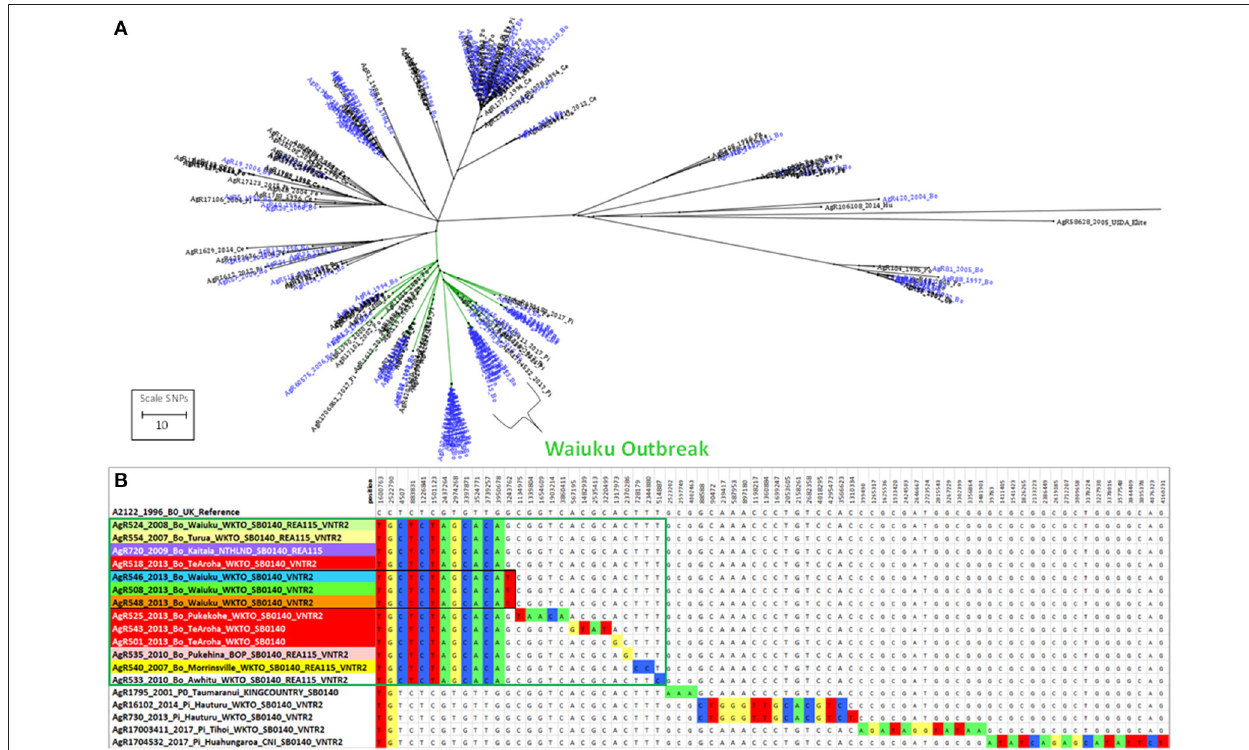
FIGURE 6 | Genetic relationship of Waiuku outbreak Isolates. (A) Radial ML Phylogram illustrating the genetic relationship of M. bovis isolates from the Waiuku outbreak to other livestock and wildlife isolates in the Central North Island cluster. Livestock metadata are colored blue and wildlife metadata black. Waiuku isolates are indicated by the bracket. The green colored branch indicates the isolates that are compared in Supplementary File 3e . (B) The relationship of isolates from the Waiuku outbreak is illustrated in a SNP table with DNA bases in the table colored to indicate differences from the reference genome. Metadata for isolates from different herds that were characterized by WGS are shaded differently. Waiuku outbreak isolates characterized for this investigation are boxed in green. Isolates that are boxed in black were not known to be linked by movement but were from farms within 4km of one another.